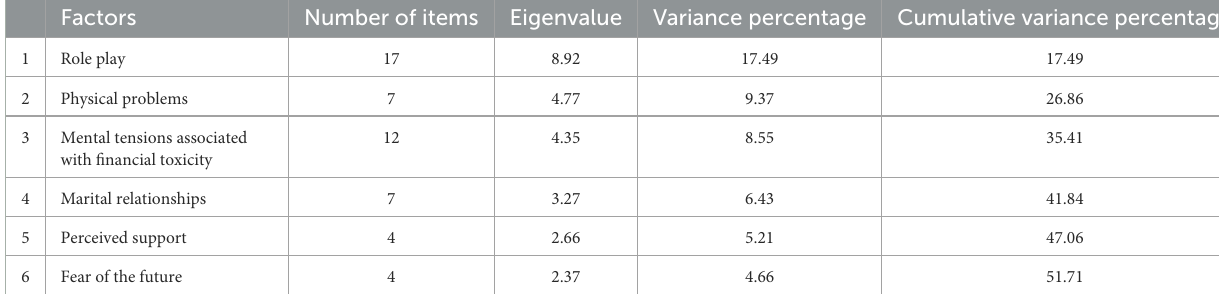
TABLE 2 The extracted factors and their eigenvalues, variance percentages, and cumulative variance percentages. Factors Number of items Eigenvalue Variance percentage Cumulative variance